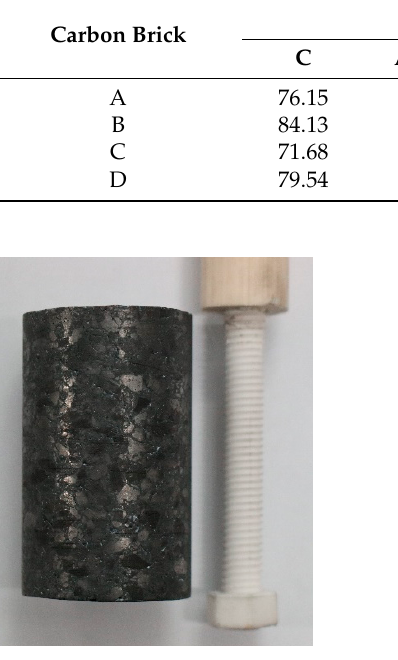
Figure 1. Carbon brick sample and matching ceramic rod.